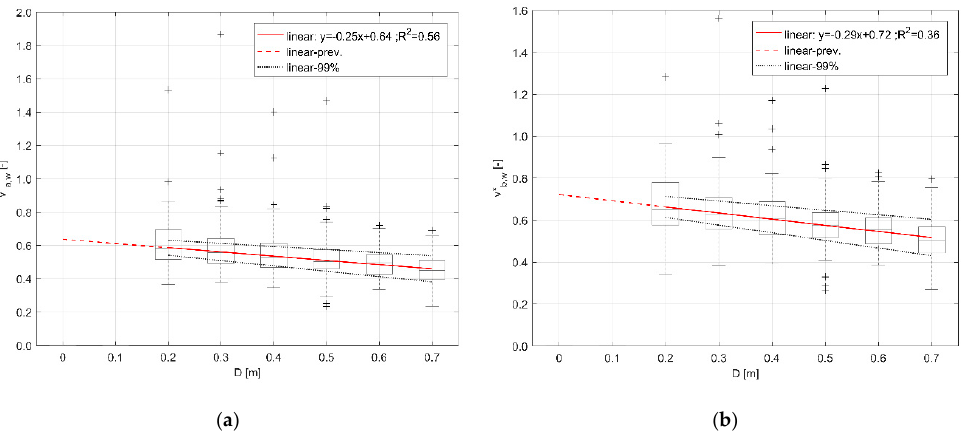
Figure 6. Normalized speed variation for walking conditions depending on D in respect to dry surface motion conditions, for the whole sample (male and female together): ( a ) according to the curve a [46]; ( b ) according to the curve b [43]. Linear regressions (dashed lines refer to prevised values outside of the tested D range) and boundary conditions (99%) are shown. Outliers are shown in the boxplot representation (marked by “ +